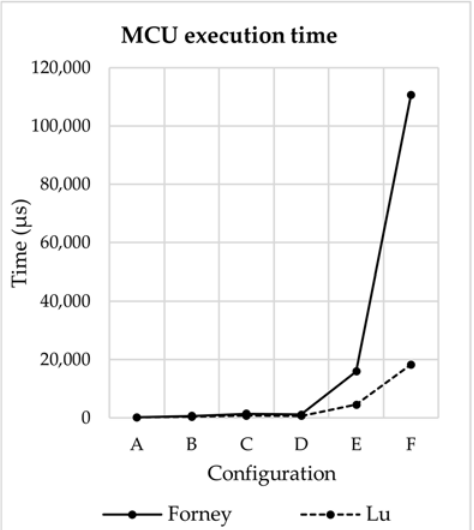
Figure 13. Graphical representation of the results of Table 5 regarding the MCU implementations’ code execution time.